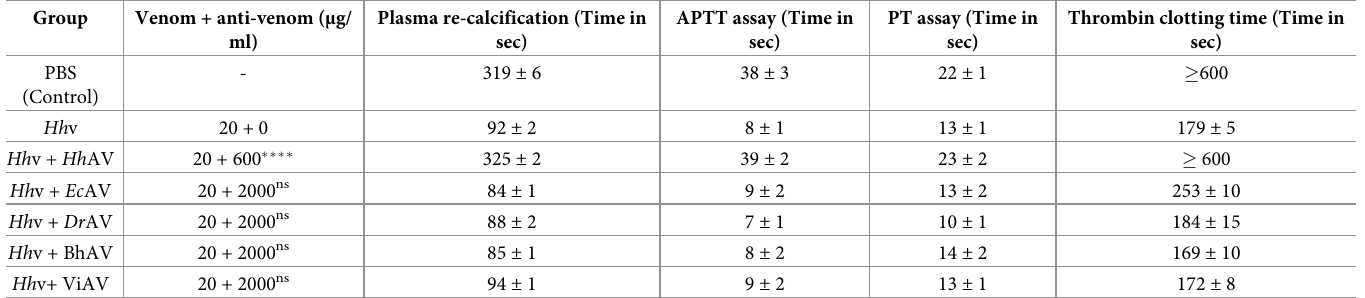
Table 2. Neutralization of coagulant activity (Plasma re-calcification time, APTT, and PT assays), and thrombin-like activity of H . hypnale venom by anti-venoms: Hh v was independently pre-incubated with various doses (100–2000 μ g/ml) of Hh AV, Ec AV, Dr AV, BhAV, and ViAV for 15 min at room temperature. In all cases, 20 μ g/ml of Hh v alone was considered as 100% coagulant activity and thrombin-like activity. The data is presented as Mean ± SEM (n = 4) and analyzed using one-way ANOVA followed by Bonferroni post-tests, ‘ ���� p < 0.0001, ��� p < 0.001, �� p < 0.01, � p < 0.05, and ns (not significant) p > 0.05. ‘ � ’ significant compared to the control group (PBS). ‘ � ’ significant compared to Hh v+ Hh AV.